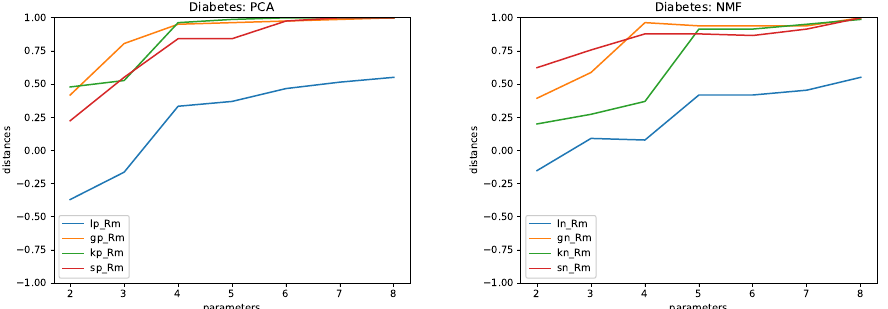
Figure 5. Rank correlation of mean Shapley values (_Rm) for data protected using PCA ( left ) and NMF ( right ) considering the four types of machine learning models: linear regression (letter l), SGD Regressor (letter g), Kernel Ridge (letter k), and SVM (letter s). Computations for the Diabetes file.